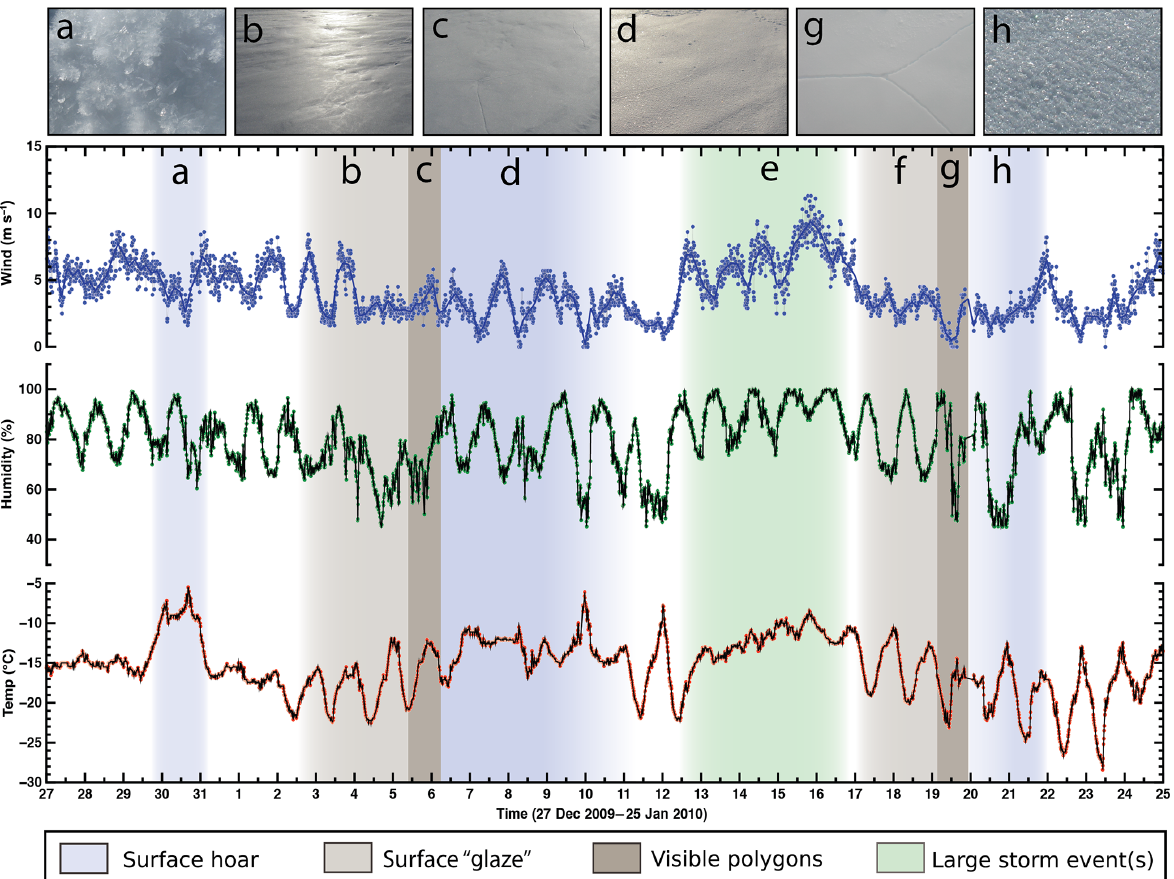
Figure 5. Surface evolution over 29 days in the 2009–2010 season, and AWS data. Shading shows episodes of surface hoar, glazes, and polygonal cracking; storm events are also shown. Letters near the top refer to photographs above of specific features or events. All dates and times are GMT (WAIS local time − 12h). The errors for all AWS instruments are listed in Table